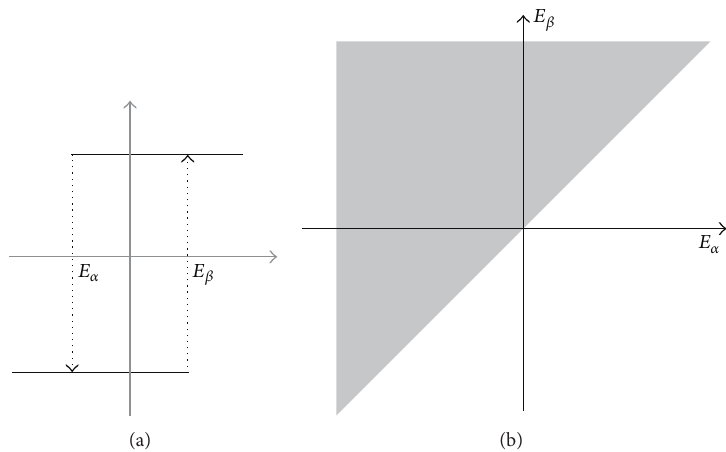
Figure 1: Illustrations of (a) relay operator as a hysteron operating in the Preisach model and (b) Preisach plane where all hysterons are plotted on the 𝐸 𝛽 ≥ 𝐸 𝛼 area (labeled in